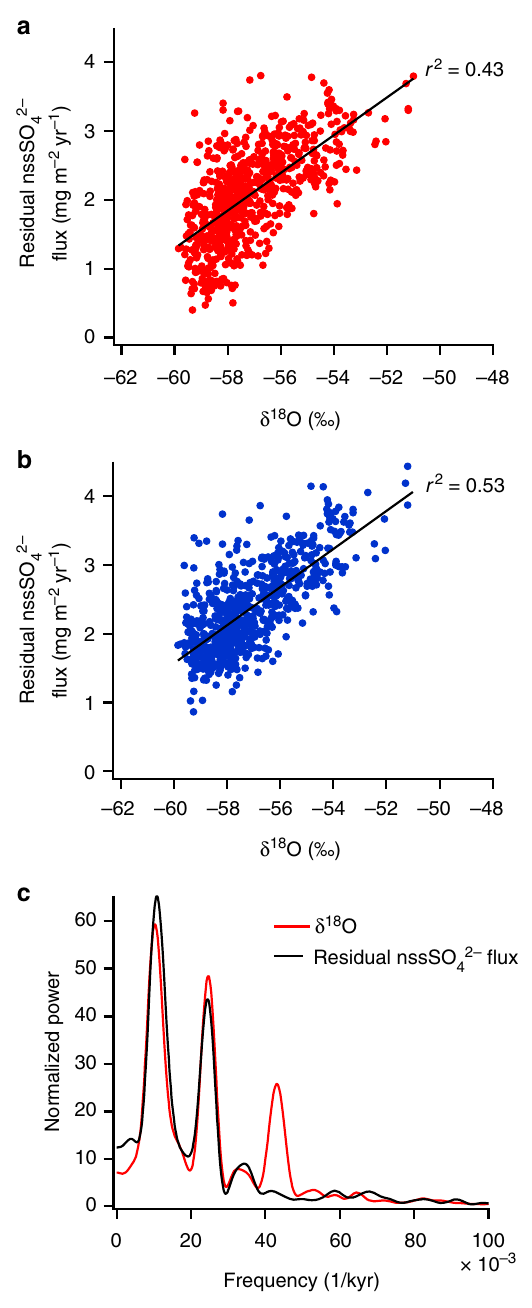
Fig. 4 Relationship between residual nssSO 4 2 − fl ux and δ 18 O at Dome Fuji (DF). a Residual nssSO 4 2 − fl ux, considering only the terrestrial CaSO 4 contribution, plotted against δ 18 O 14,15 . b Residual nssSO 4 2 − fl ux considering the contributions of CaSO 4, MgSO 4 , Ca(NO 3 ) 2 , and Mg(NO 3 ) 2 plotted against δ 18 O 14,15 . Residual nssSO 4 2 − fl ux and δ 18 O are averages over 1000 years. Before averaging, the δ 18 O depths that differ from the ion data depths have been interpolated to match. Straight lines in a and b display results of linear regressions. Correlation coef fi cients ( r ) were calculated with sample size ( n ) = 681 and for signi fi cance level ( α ) = 0.05. c Normalized power spectra of residual nssSO 4 2 − fl ux and δ 18 O at DF.